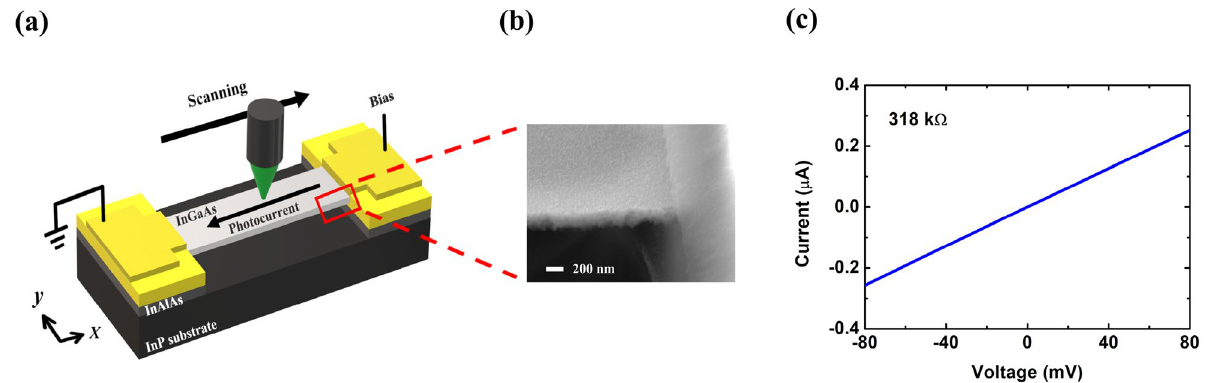
Figure 6. ( a ) Schematic of the SPCM setup in an InGaAs air-bridge two-terminal thin-film device. ( b ) SEM images for one side of the measured InGaAs air-bridge two-terminal thin-film device. ( c ) I–V characteristics. L ch of the measured thin-film device is 15 μm, and the width is 5 μm. *( a ) is created using Microsoft Paint 3D ver. 6.2105.4017.0-URL: https:// www. micro soft. com/ en- us/p/ paint- 3d/ 9nblg gh5fv 99? cid= msft_ web_